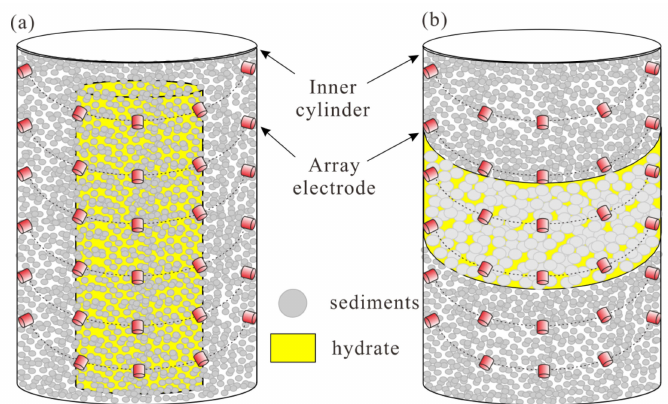
Figure 2. Models of massive hydrate in ( a ) and layered hydrate in ( b ). Large circles represent coarse-grained quartz sands. Small circles represent fine-grained